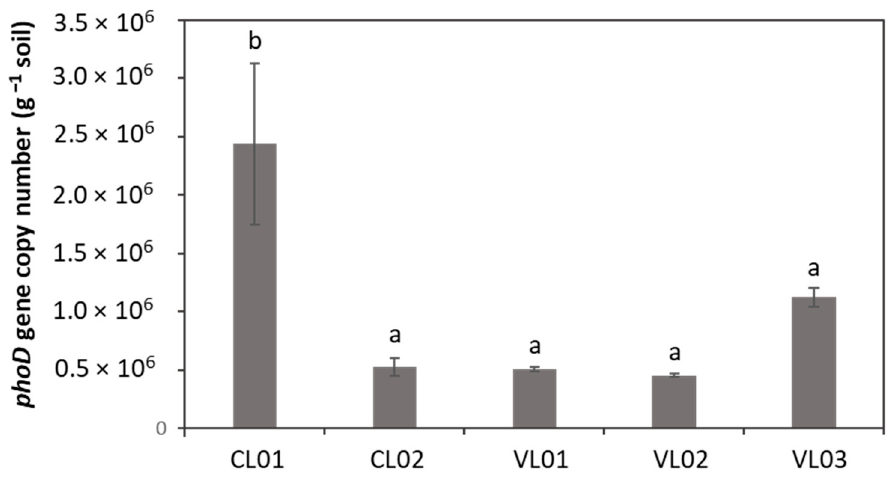
Figure 4. PhoD gene abundance. Each value represents the average ± standard deviation (n = 3). Different letters indicate significant differences ( p < 0.05). No Ct values could be obtained in the case of sample CL03, thus, it was not included in the calculation of phoD abundance. Different letters above columns represent significantly different ( p < 0.05) values.